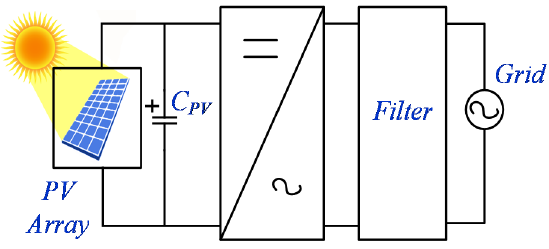
Figure 12. Block diagram of a single-stage topology for an alternating current (AC) module.